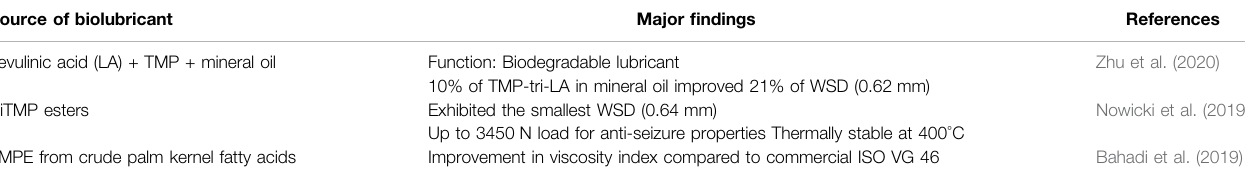
TABLE 3 | Tribological improvement of food grade biolubricants.